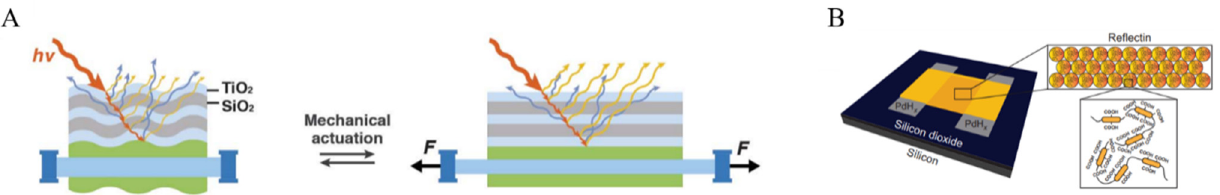
Figure 7. ( A ) Surface reflection before and after the mechanical stretching of the TiO 2 /SiO 2 composite sheet layer [25]; Copyright 2018, Science Publishing Group. ( B ) Biological semiconductor based on the film layer of reflectins [34]. Copyright 2014, Nature Publishing Group.